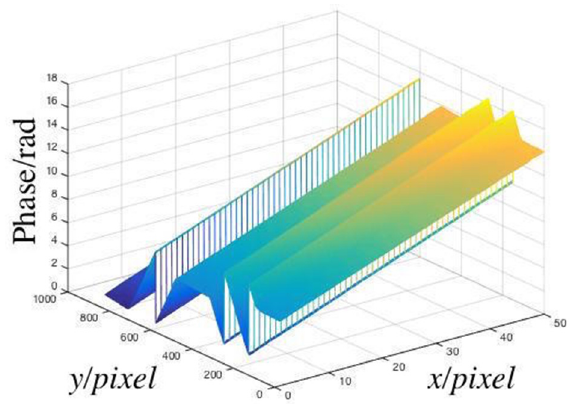
Figure 4. ( a ) Measured object; ( b ) grating fringe pattern of the measured object.